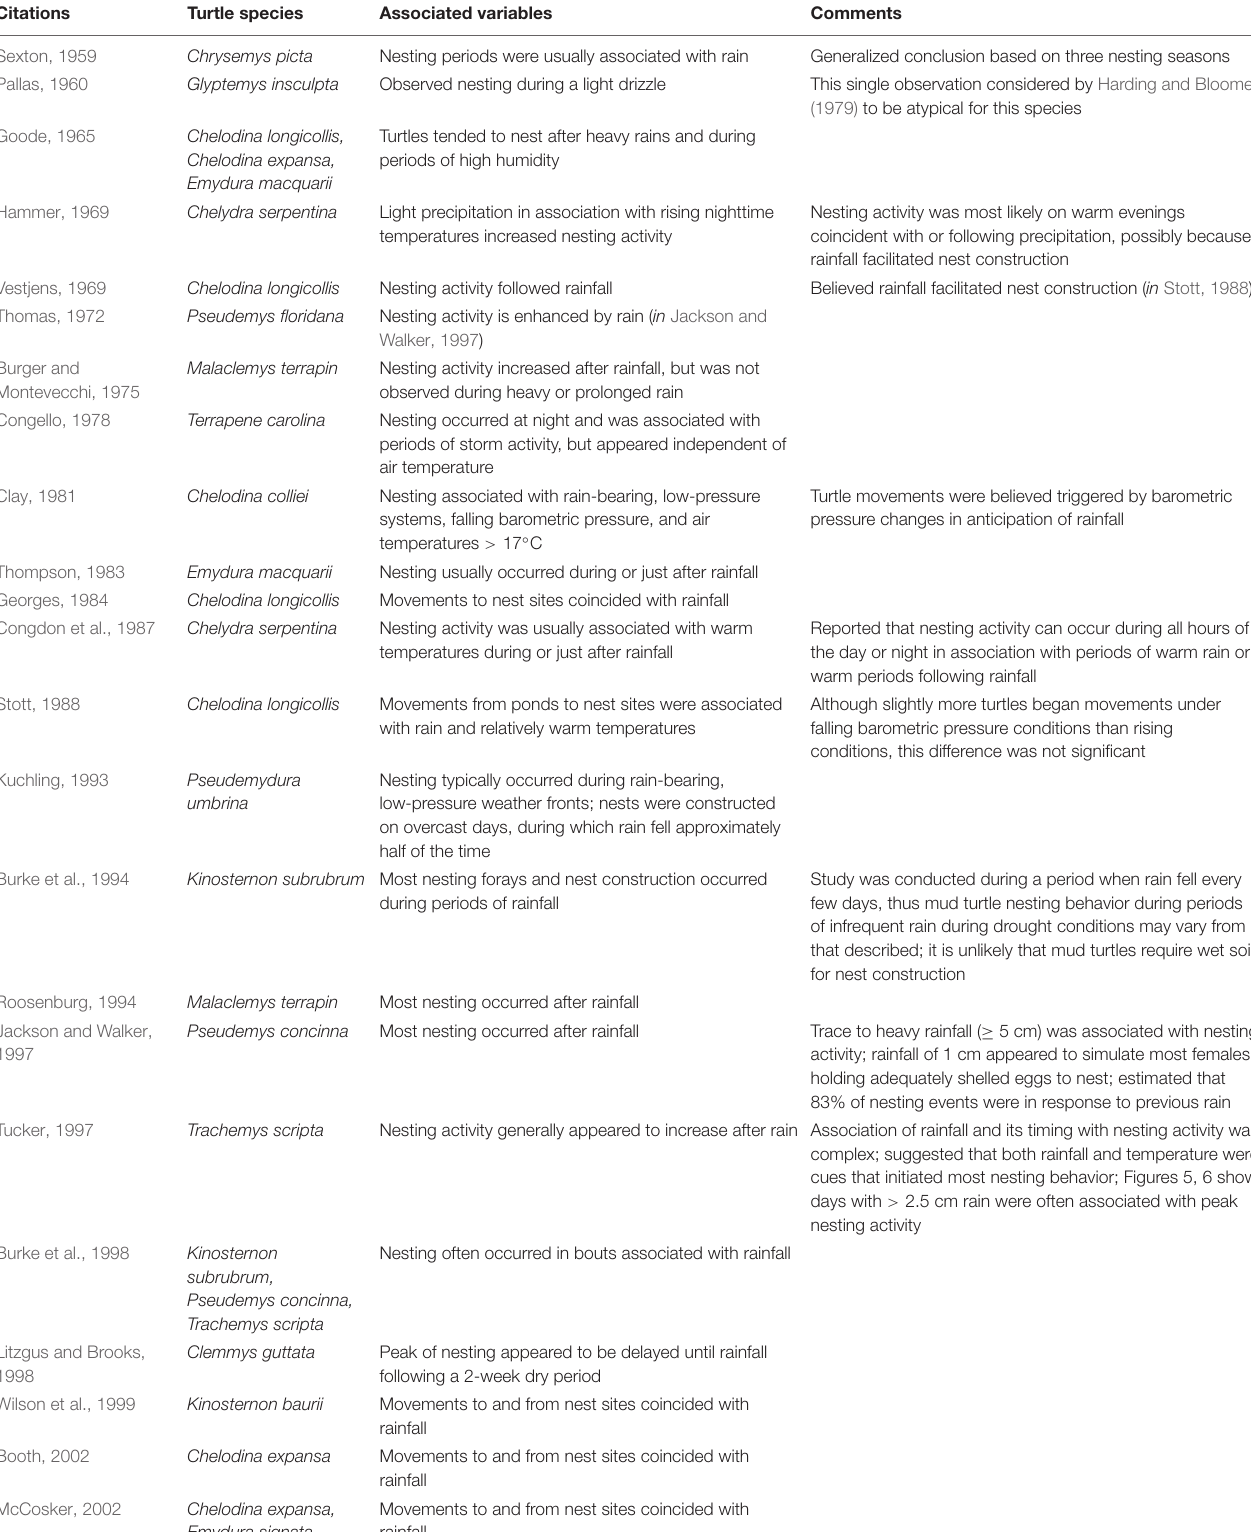
TABLE 1 | Papers suggesting freshwater turtles nest in association with